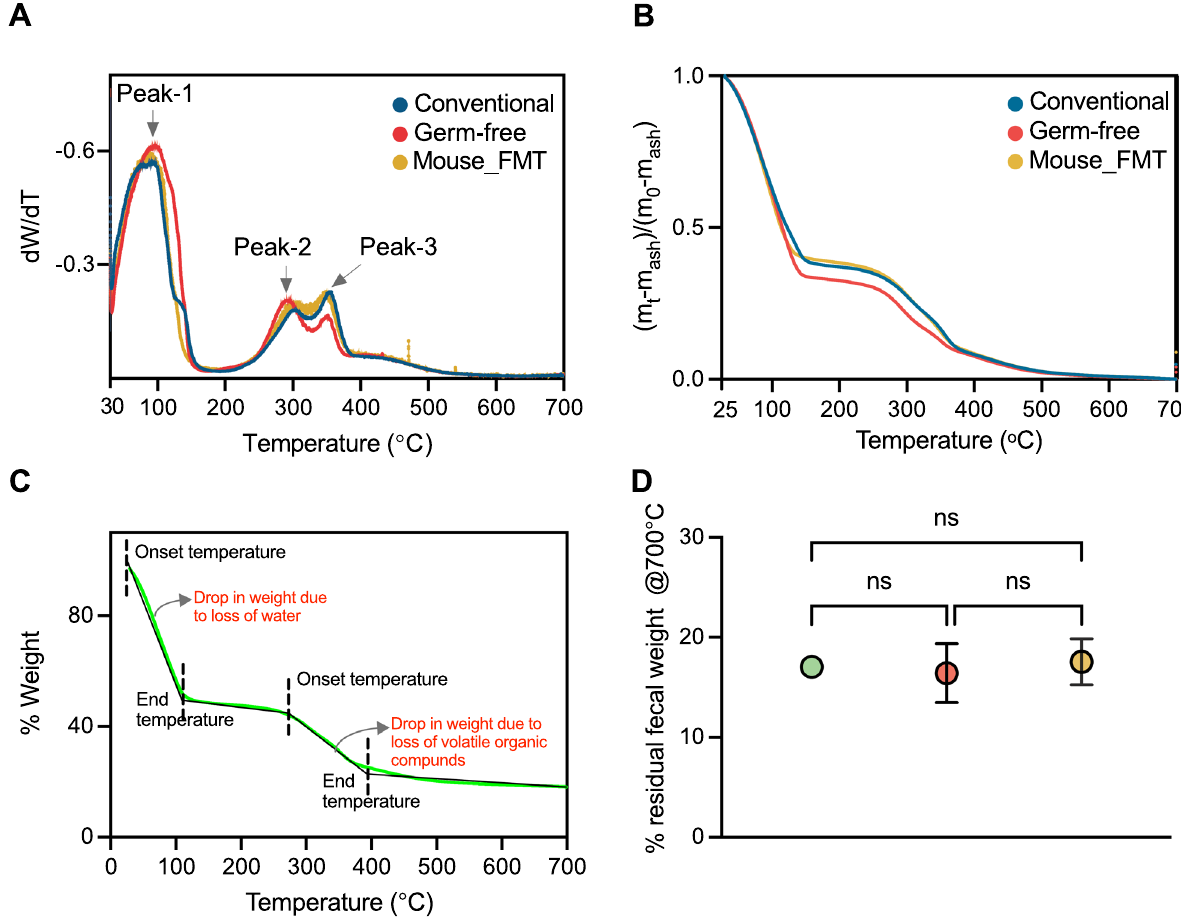
Figure 4. Thermogravimetric analysis (TGA) of fecal samples. ( A ) Representative plot showing decrease in percent weight with increase in temperature (°Celsius; °C) during the TGA of fecal samples under pyrolysis conditions. ( B ) Effect of heating rate on the change of mass with increasing temperature for conventional, germ- free and mouse FMT fecal samples. Data is depicted in dry ash free basis. ( C ) Derivative thermogravimetric plot for weight loss against increasing temperatures for three groups. ( D ) Percent residue fecal weights obtained from standard TGA curve for three groups. Repeated measures one-way ANOVA was performed for comparisons between the samples and ns = not